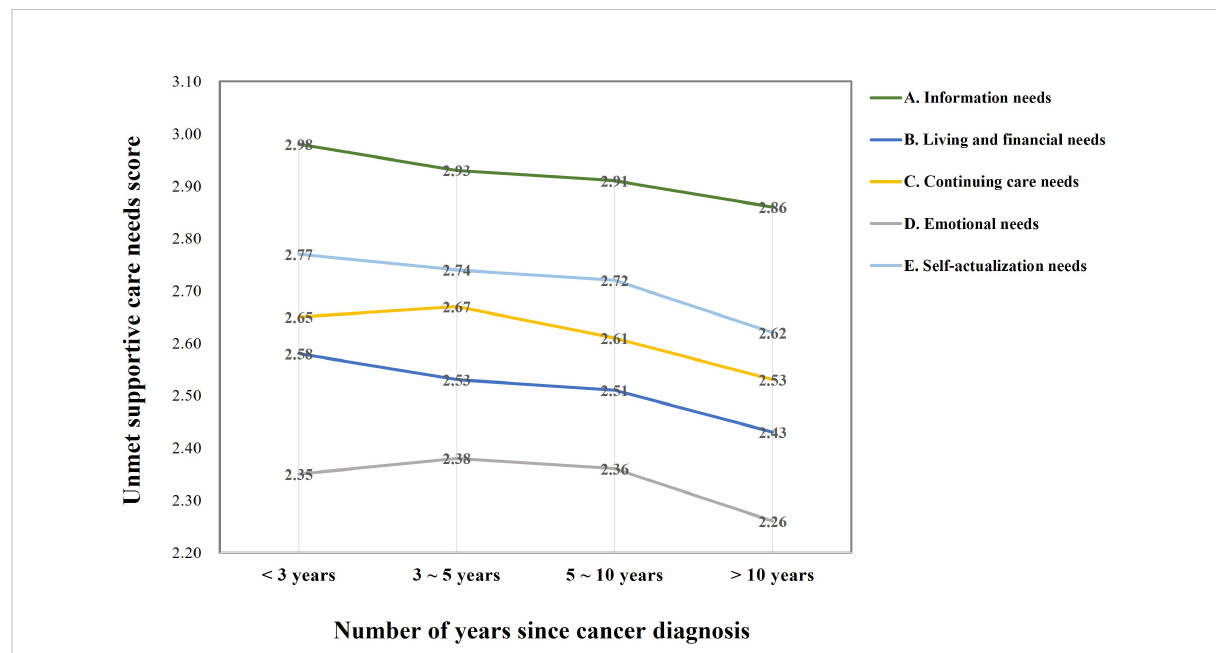
FIGURE 1 Unmet supportive care needs by time since cancer